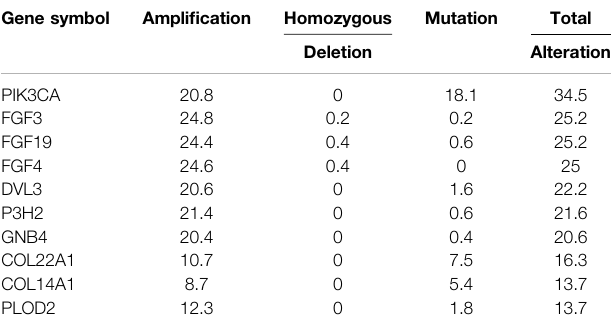
TABLE 1 | The top 10 type and frequency of mRNAsi related neighbor gene alterations in HNSCC (cBioPortal). Gene symbol Ampli fi cation Homozygous Mutation Total